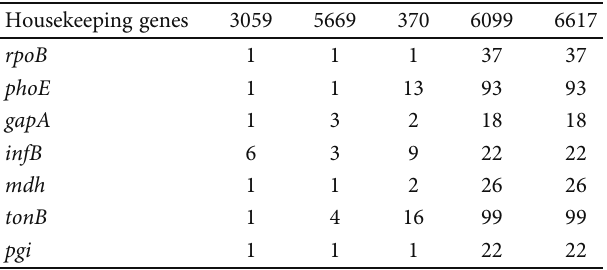
Table 2: Homology of